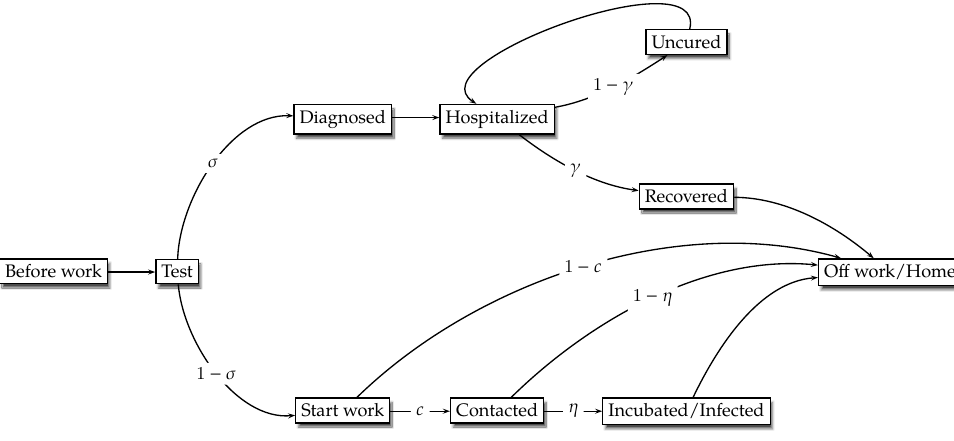
Figure 3. The COVID-19 transmission road